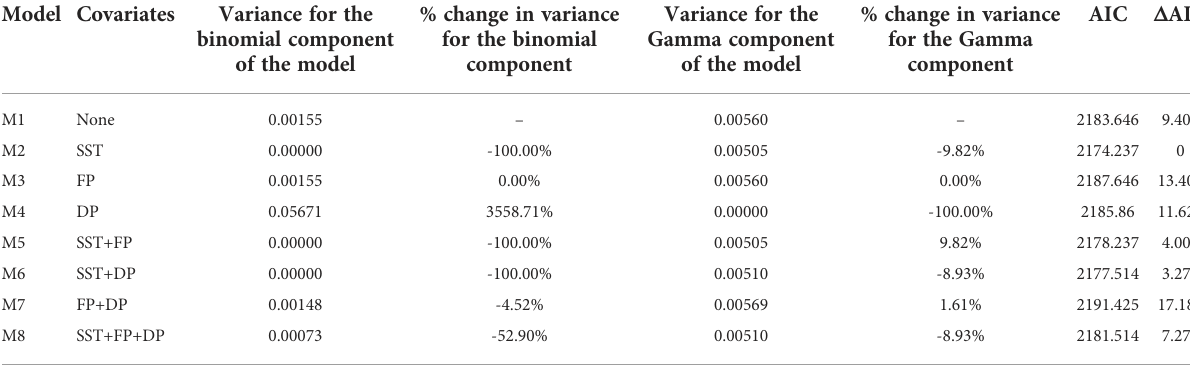
TABLE 1 Estimates of the variances and model performance based on Akaike ’ s Information Criterion (AIC) for the eight candidate geostatistical delta-GLMMs (M1 – M8) developed in this study. Model Covariates Variance for